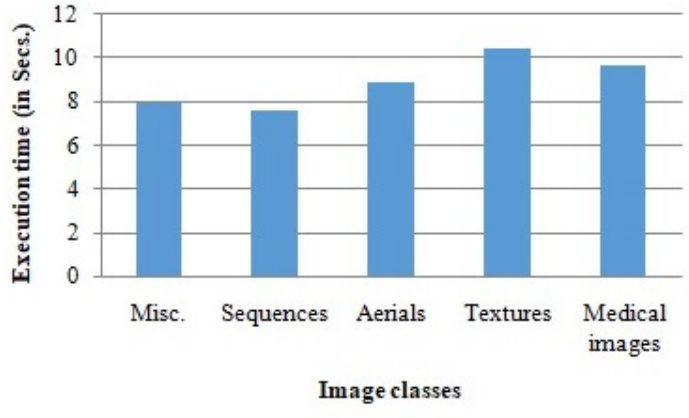
Figure 12. Average execution time of the proposed scheme in various image